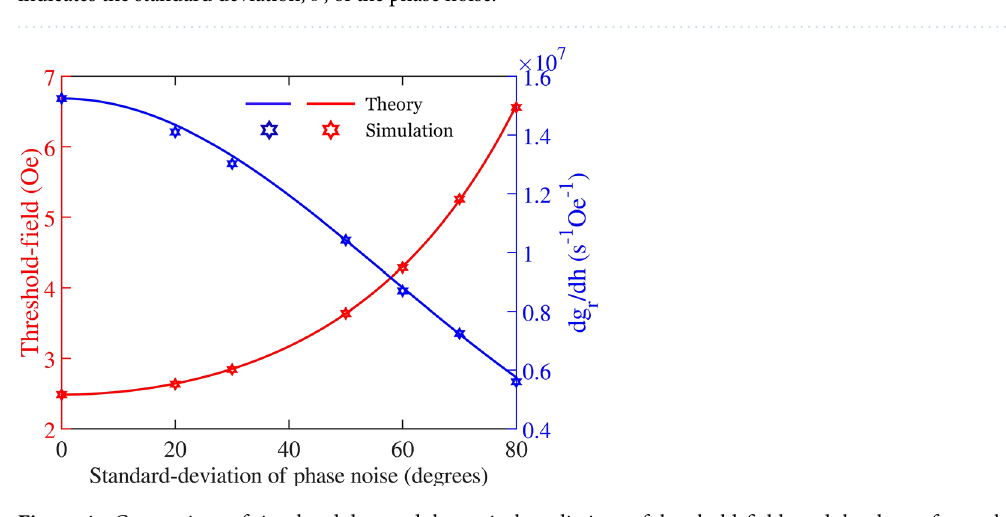
Figure 4. Comparison of simulated data and theoretical predictions of threshold-fields and the slope of growth rate, dg r dh w.r.t microwave field